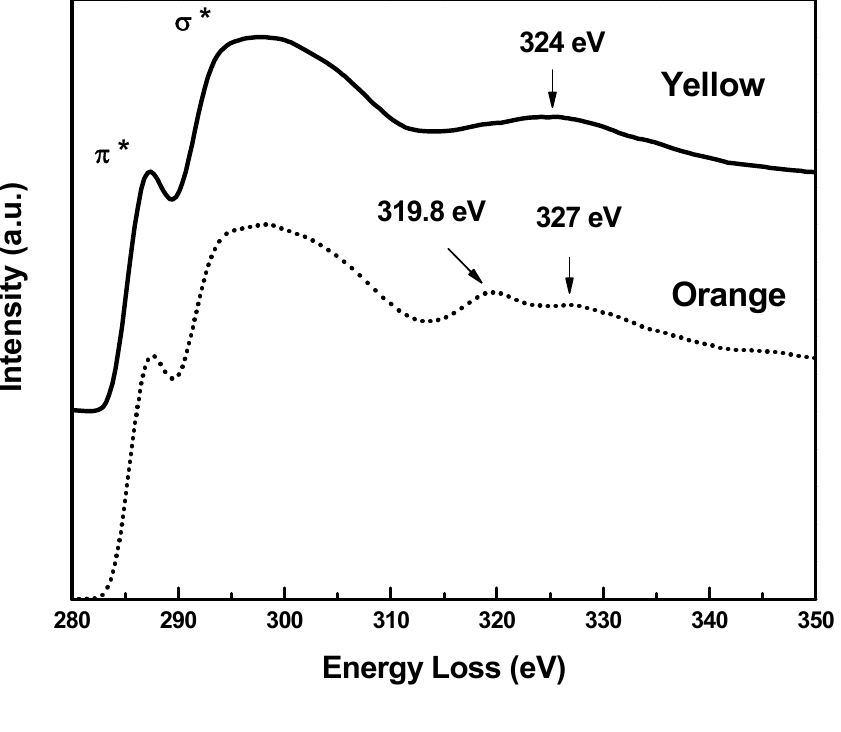
Figure 5. Carbon K Ionization edge, showing 1s- π * and 1s- σ * peaks. Signaled energies correspond to MSR peaks in yellow (continuous) and orange (dotted)